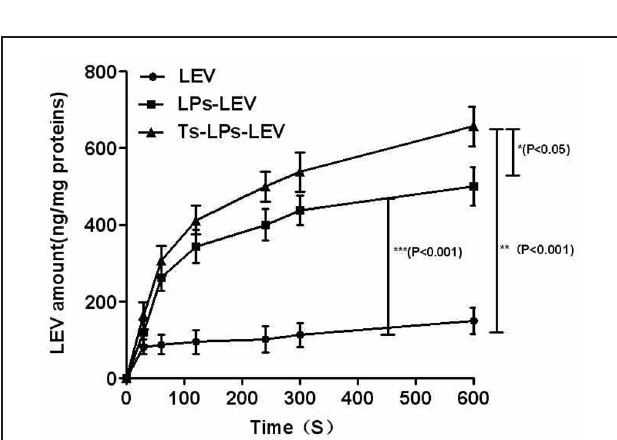
FIGURE 6 | Intra-bacterial levofloxacin accumulation of levofloxacin in K. pneumoniae ATCC 700603. Error bars represent the standard deviation of three